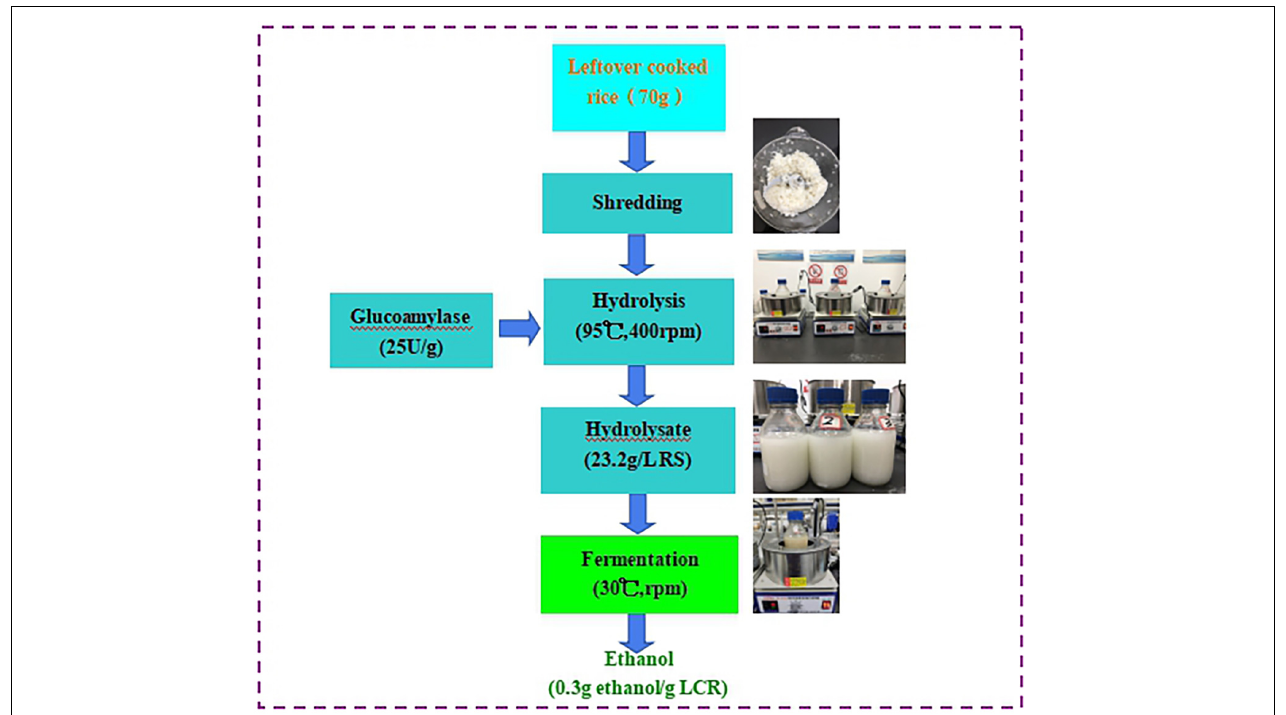
FIGURE 1 | Schematic diagram and materials balance of fermentative ethanol production from enzymatic hydrolysis of leftover cooked rice with the enzyme volume of 25 U/g (V2). No sterilization and additional pH buffer and supplement were applied in this